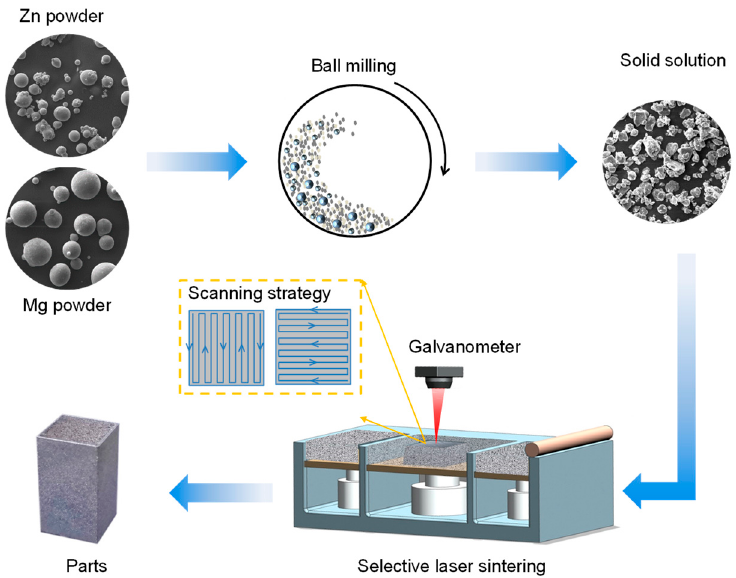
Figure 1. Schematic map showing the preparation process for laser-sintered Mg-Zn parts.